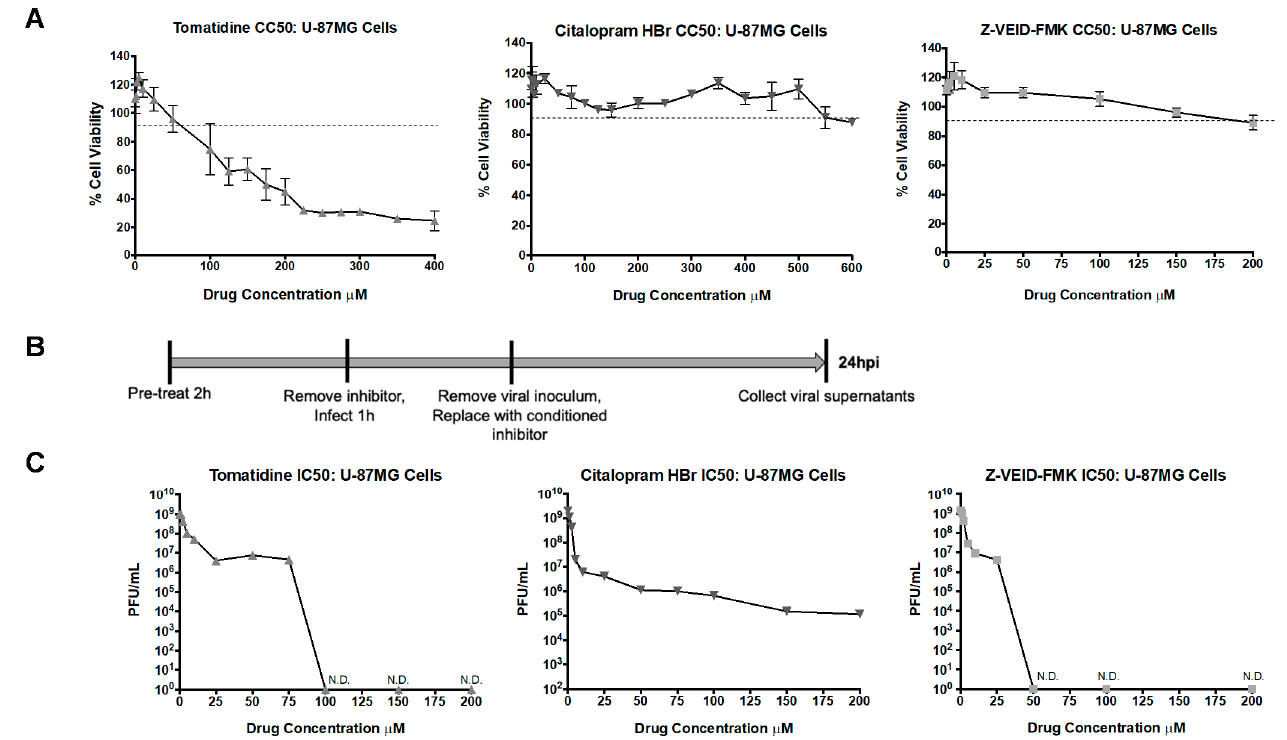
Figure 4. Selectivity indexes of tomatidine, citalopram HBr, and Z-VEID-FMK against VEEV TC-83. U-87MG cells were treated with varying micromolar concentrations of tomatidine, citalopram HBr, and Z-VEID-FMK. ( A ) cell viability was measured at 24 hpt and calculated versus the DMSO vehicle control, as described in Materials and Methods. The dotted line represents the 90% cut-off point. ( B ) Schematic of infection scheme (MOI 0.1). ( C ) Viral supernatants were collected at 24 hpi and evaluated by plaque assay, as described in Materials and Methods. Graph represents data from two independent experiments performed in triplicate ( n = 6).